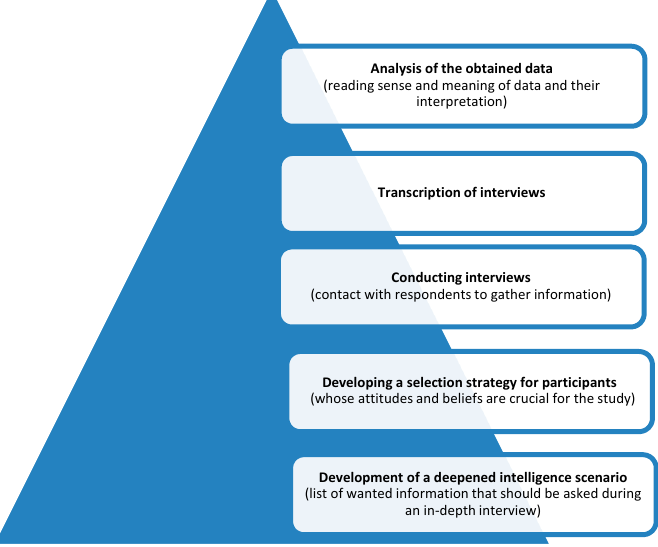
Figure 1. Stages of conducting the study using in-depth interview.